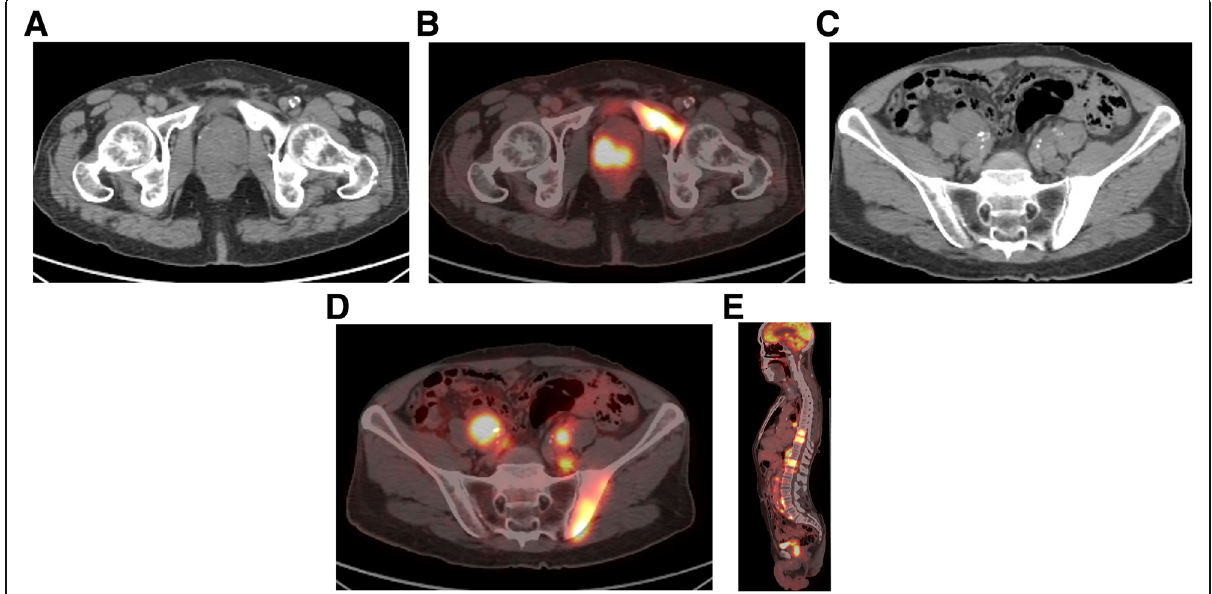
Fig. 4 A 71-year-old male patient presented with pathologically proven metastatic carcinoma left supraclavicular lymph node. PET/CT revealed axial CT ( a ) and fused PET/CT ( b ) images showing FDG avid metabolically active prostatic lesion (SUVmax 17.1 suggested site of primary malignancy) as well as left pubic ramus metastatic deposit. Axial CT ( c ) and fused PET/CT ( d ) images showing metabolically active left iliac bone and iliac nodal metastatic deposits (SUVmax 16.65). Sagittal fused PET/CT ( e ) image showing metabolically active multiple osseous metastatic deposits. Transrectal US prostatic biopsy confirmed prostatic adenocarcinoma